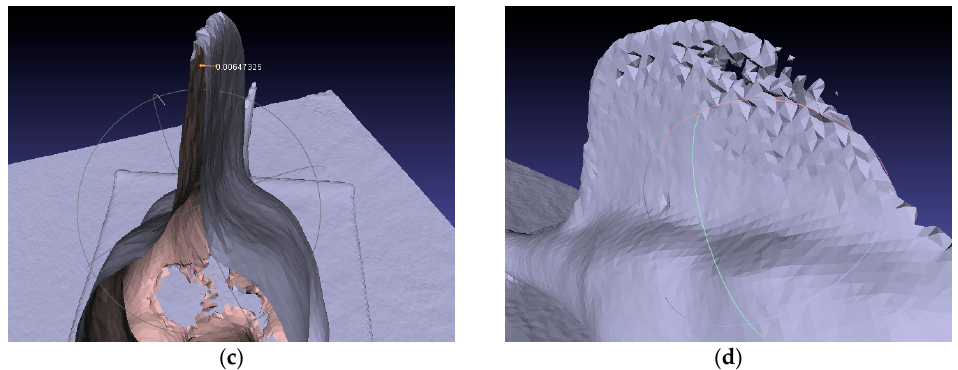
Figure 13. A failure case of our approach when scanning a Spinosaurus model with thin spines on its back. ( a ) Color (not used) and ( b ) depth image at time k = 912. Slightly faster camera motion around time k leads to mild motion blur, as can be seen from the color image; ( c ) A sectional view of part of the reconstruction before time k . Note how accurately our approach reconstructs the thin spines of the model; ( d ) A profile view of the reconstruction failure of the spine area at time k .